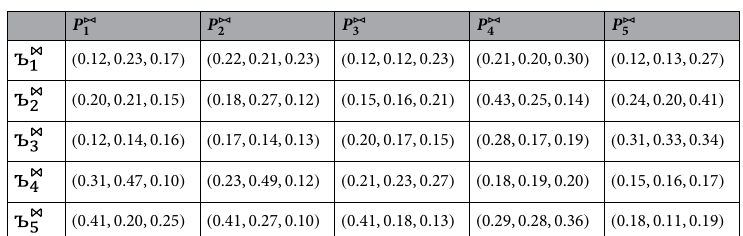
Table 2. Picture fuzzy soft data for F